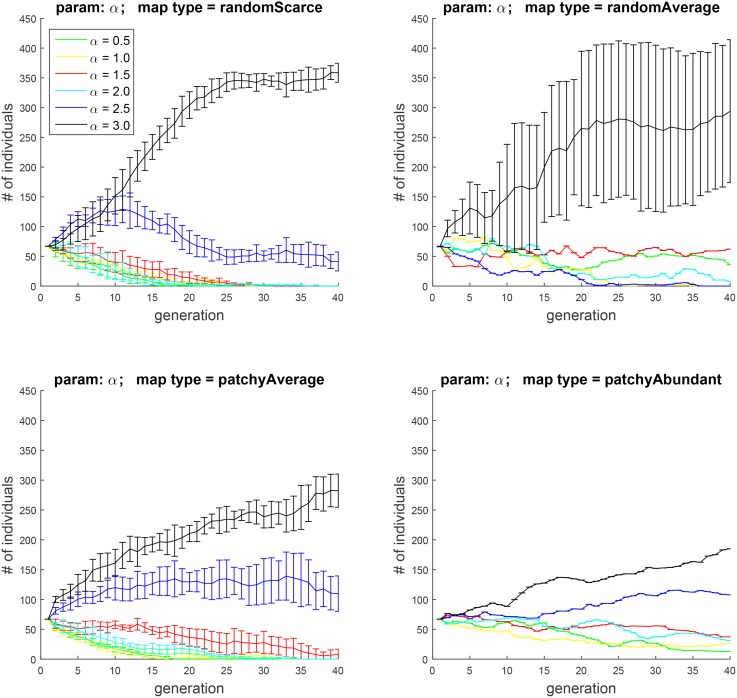
Experiment 2A: the effect of the parameter α, which sets the contribution of food rewards to H.As before, the plots show, for each successive generation, the mean cohort sizes and 95% confidence intervals over 10 runs. The results indicate that letting food contribute more strongly to hedonic well-being, and hence to motivation, is more advantageous under conditions of food scarcity.